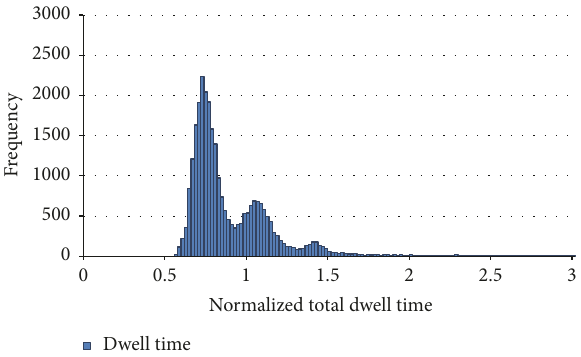
Figure 21: Historical distribution of total terminal dwell time of